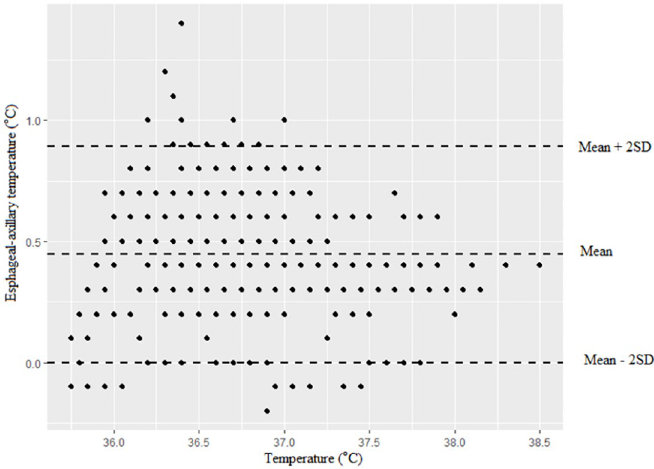
Fig 4. Bland–Altman analysis for axillary versus esophageal temperature